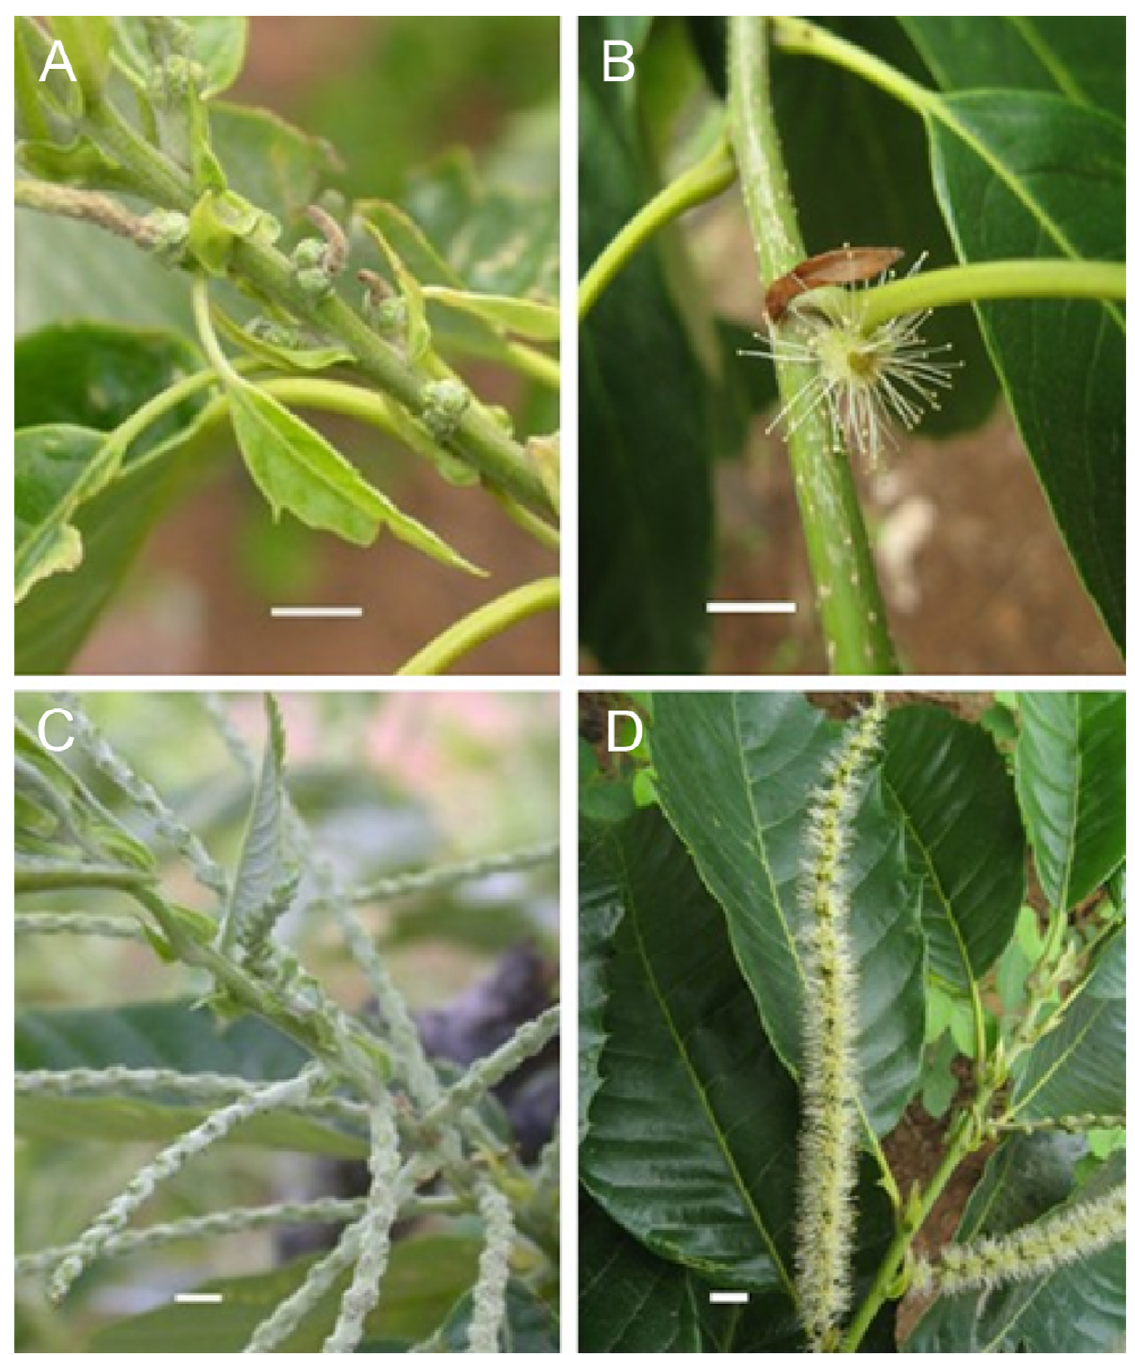
Figure 1. Comparison of catkin length between the mutant catkins and WT. ( A ) mutant catkins before flowering. ( B ) mutant catkin in flowering. ( C ) wild-type catkins before flowering. ( D ) wild-type catkins in flowering. Bar =1 cm.